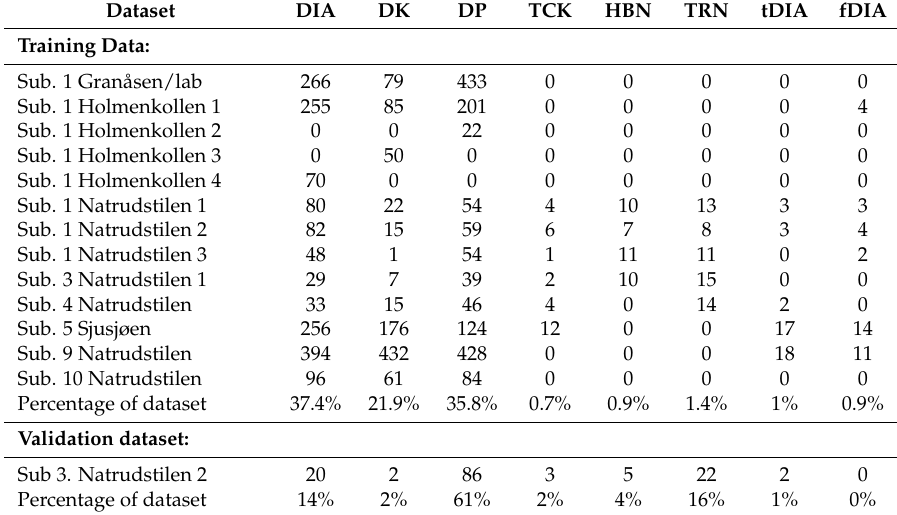
Table 1. Table summarizing the datasets from the six subjects used to train the neural network and details of the validation dataset. Each row represents one separate dataset, and the columns indicate how many cycles belong to each